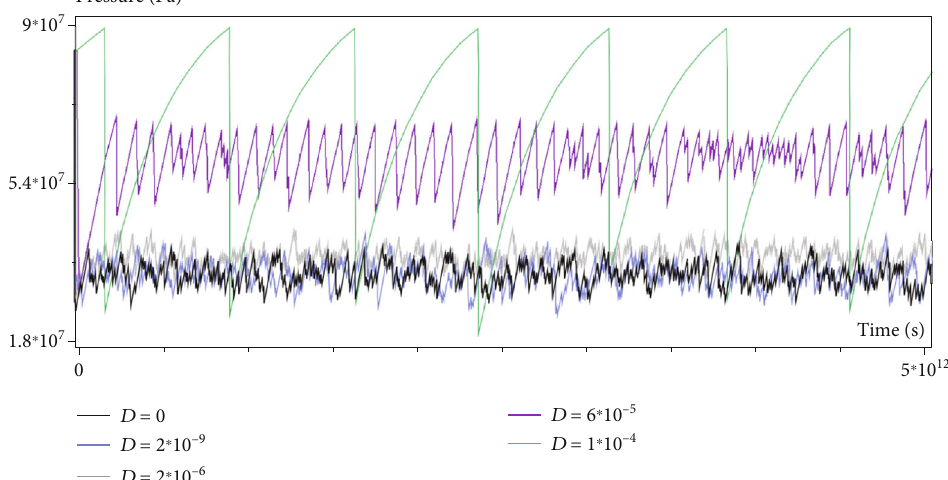
Figure 4: Mean pressure in the whole model as a function of time. No and little di ff usion produces an intermittent and irregular behaviour. Higher di ff usion coe ffi cients result in more periodical pressure fl uctuations.